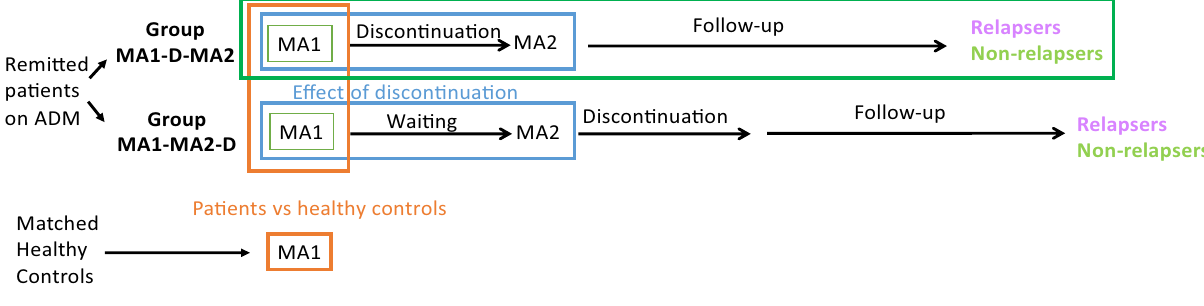
Figure 1. Study Design: Remitted patients on antidepressant medication (ADM) and matched healthy controls were included in the study and assessed during main assessment 1 (MA1). Patients were randomised to groups MA1-D-MA2 or MA1-MA2-D, where the name indicates the order of events and "D" indicates discontinuation. In group MA1-D-MA2, they underwent MA1, then discontinued their medication followed by main assessment 2 (MA2). In group MA1-MA2-D, they underwent MA1 and MA2 first and only discontinued thereafter. After discontinuation, all patients were followed up for six months to ascertain relapses. Comparison of patient and control groups at MA1 was used to examine the remitted medicated state cross-sectionally (orange). Data collected at MA1 from all patients who subsequently completed the study as relapsers or non-relapsers, i.e. relapsers and non-relapsers from both groups combined were examined to examine associations with relapse. The interaction between time point (MA1 and MA2) with group (MA1-D-MA2 and MA1-MA2-D) examined the impact of discontinuation (blue). Finally, the interaction between time point (MA1 and MA2) and relapse in group MA1-D-MA2 was used to examine changes due to discontinuation that led to relapse or resilience (dark green).